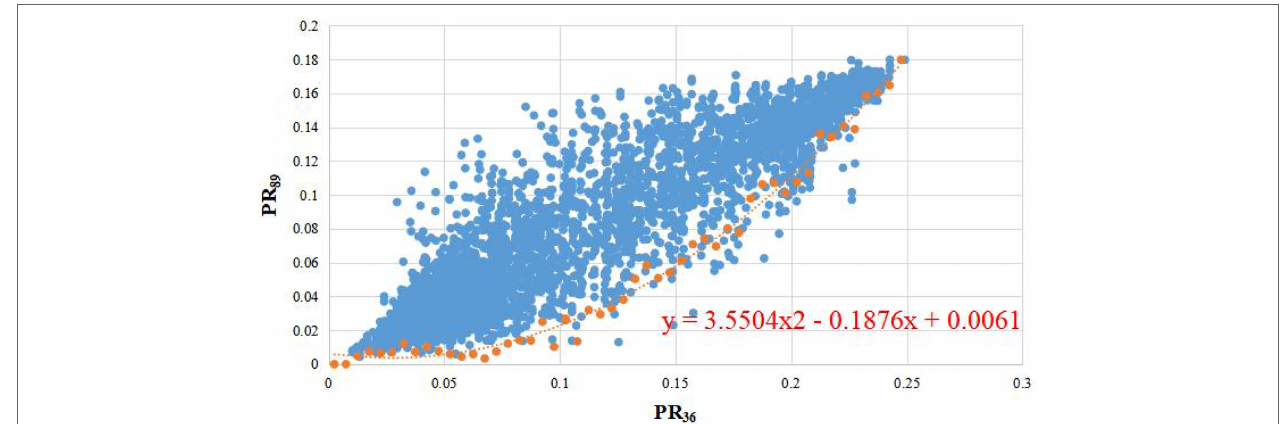
FIGURE 1 | Scatter plot of PR.